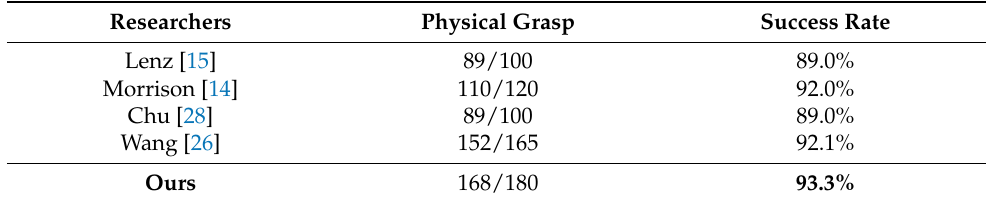
Figure 9. Example of the robotic grasp process. ( a ) shows the initial state of the robot. ( b ) illustrates the robot’s gripper has moved to the target to be grasped. ( c ) shows the state of the object being grasped. ( d ) demonstrates the target being moved to another location. Table 4. Grasp success rates in robotic grasping experiments .